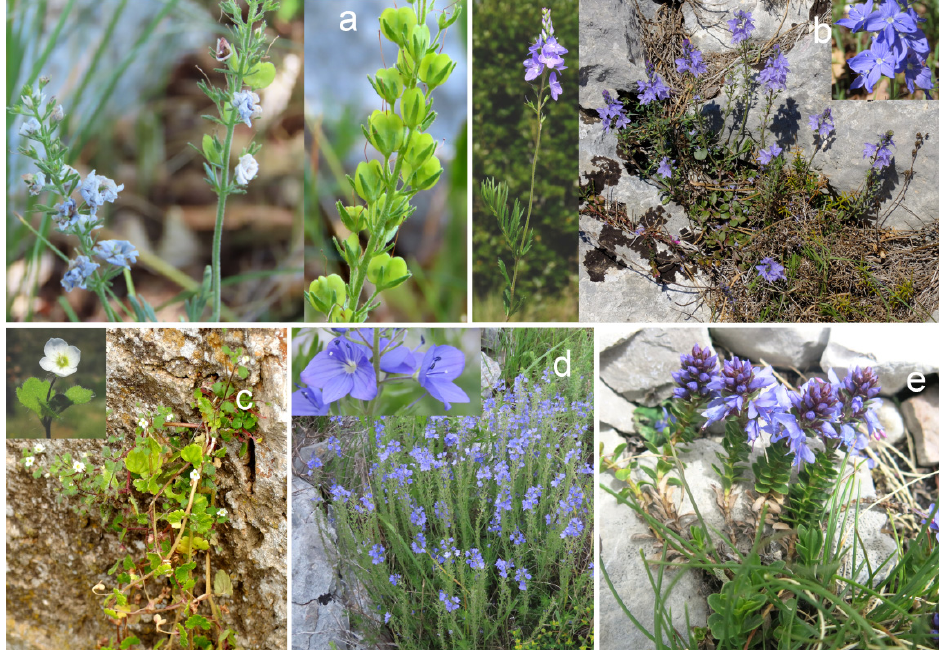
Figure 1. Photographs of Veronica taxa collected from dry habitats: V. austriaca ssp. austriaca ( a ), V. austriaca ssp. jacquinii ( b ), V. cymbalaria ( c ), V. dalmatica ( d ), and V. saturejoides ssp. saturejoides ( e ).